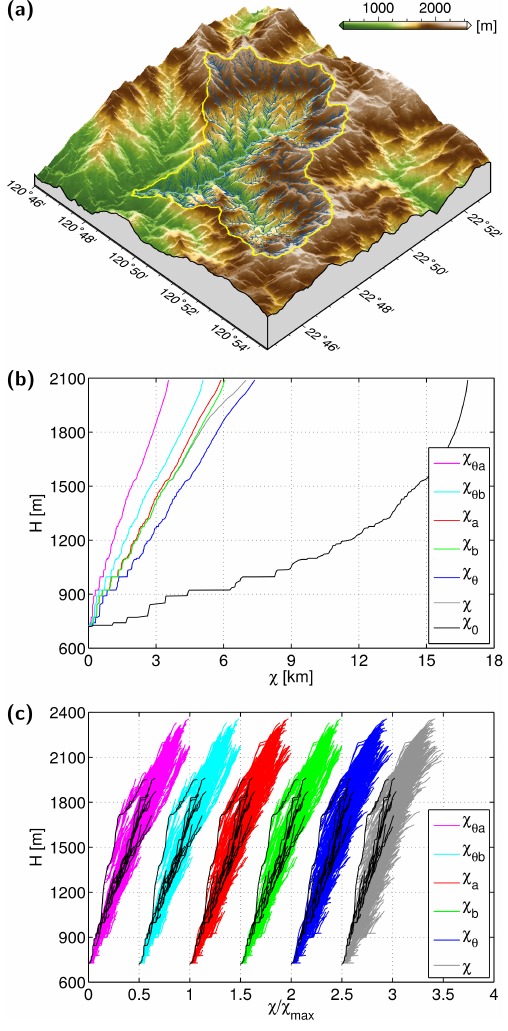
Figure 5. A catchment in Taiwan with a rather high χ disorder. (a) Topography and drainage pattern for A ≥ 0 . 01 km 2 . The largest river is drawn in light blue. (b) H vs. χ plots of the main river. χ 0 refers to θ = 0, so that χ 0 = x , and the plot describes the original river profile. (c) H vs. χ plots for the entire drainage network. The plots are shifted horizontally in order to avoid overlapping curves. The black lines show the part of the drainage network with A ≥ 1 km 2